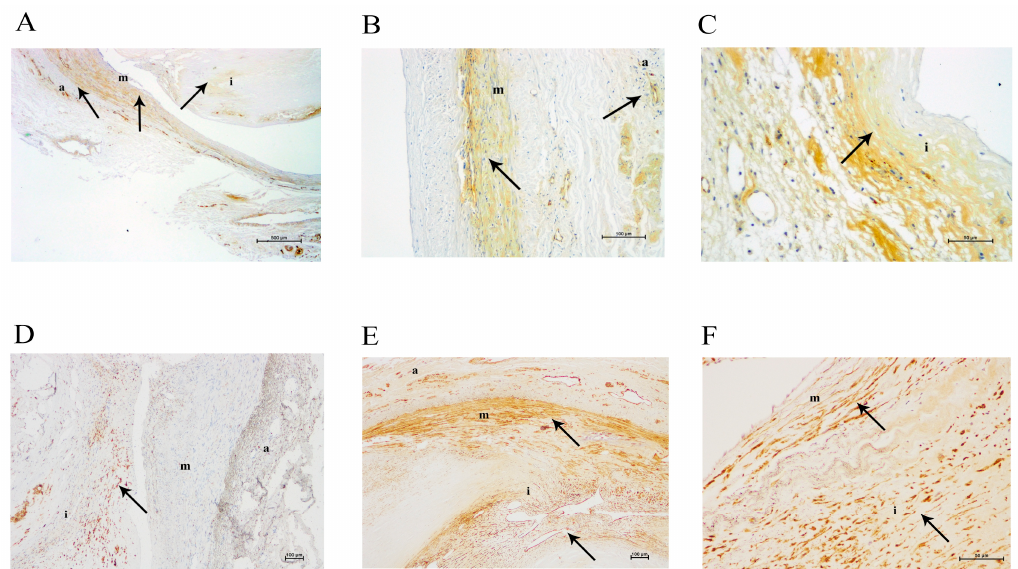
Figure 3. Immunohistochemical images of a severely altered femoral artery. ( A ) Galectin-3 staining at 40 × magnification; ( B ) galectin-3 staining in adventitia at 100 × magnification; ( C ) galectin-3 staining in tunica intima at 200 × magnification; ( D ) CD68 staining at 100 × magnification; ( E ) α -actin staining in adventitia, media, and intima at 100 × magnification; ( F ) α -actin staining in media and intima at 200 × magnification. a , adventitia; m , media; i , intima. The arrows show positive immunostained areas.